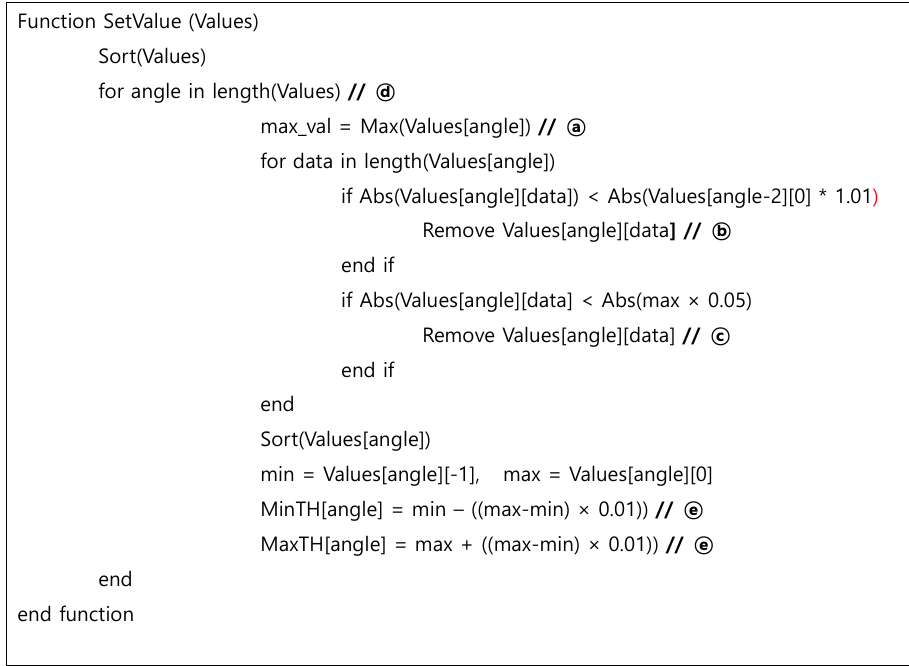
Figure 8. Pseudo codes of threshold calculation for each angle of eye movement.